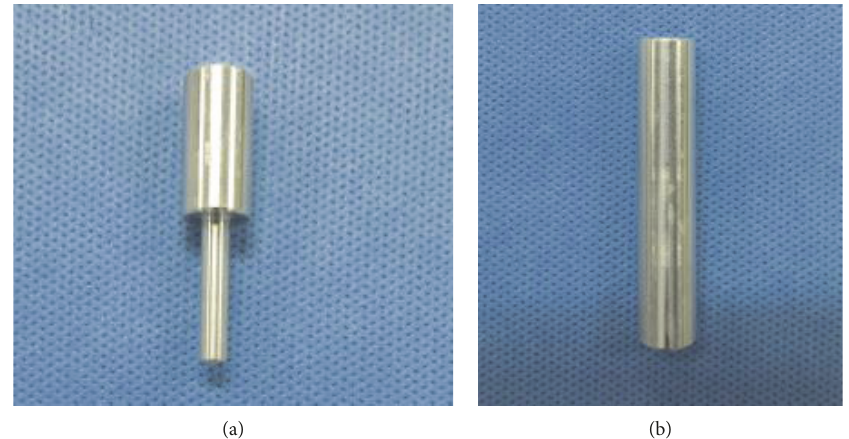
Figure 3: Femoral head compression test jig. (a) Upper jig. (b) Lower jig.